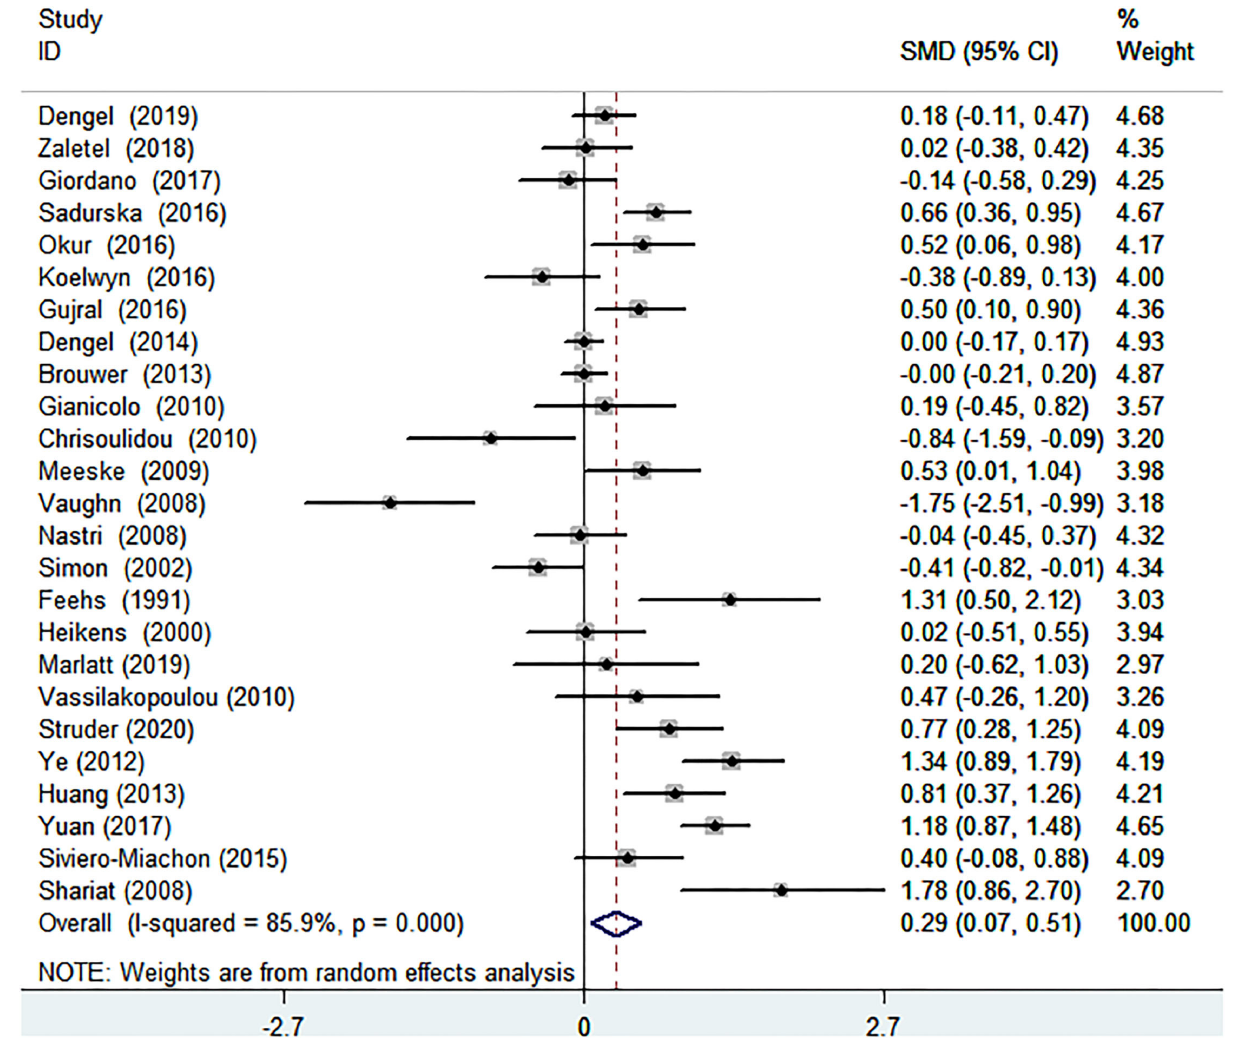
TABLE 2 | Publication bias evaluated by Begg’s and Egger’s tests. ( Table 1 ; Figure 4 ). The I 2 statistic was 88.2%. In terms of Begg Test Egger Test sub-group analyses, there was a lower FMD in the following